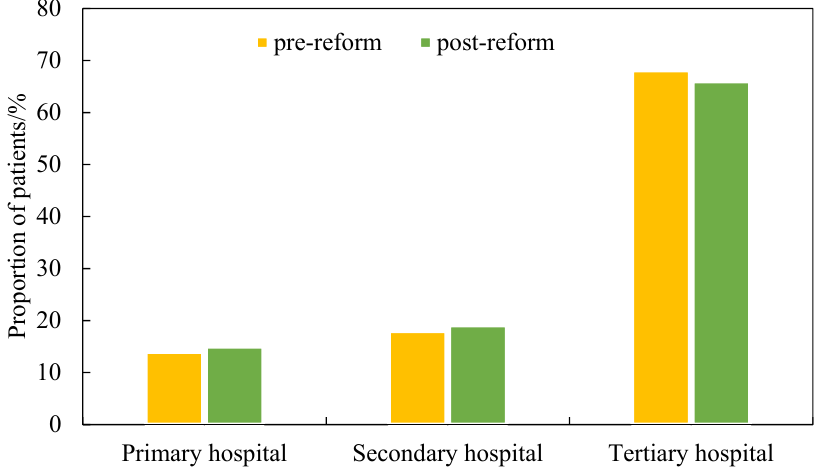
Figure 2. Distributions of patients at different levels of hospitals both pre-reform and post-reform. Spatially, the pre-reform and post-reform patterns of tertiary hospital choices were compared by computing the difference of the percentage of patients who sought healthcare in tertiary hospitals by subdistricts. This difference is presented in the form of multiples of standard deviations (Figure 3). Multiples close to 0 imply a higher degree of consistency and vice versa. This study assumes that there is no significant difference if the multiples range between − 0.5 and 0.5 [13]. After the reform, the preference for tertiary hospitals of patients who lived in subdistricts far from tertiary hospitals decreased. For example, before the reform, patients in the subdistricts Changyang and Yancun were more likely to seek healthcare in Liangxiang Hospital (i.e., a tertiary hospital), whereas the likelihood decreased after the reform. However, for patients near tertiary hospitals, the effects of Beijing’s public hospital reform in 2017 varied by core urban areas and suburban areas. The effect slightly increased the proportion of patients choosing tertiary hospitals in core areas but had no obvious effect on patients in suburban areas. This result is reasonable because the crowdedness of tertiary hospitals in core urban areas decreased after the reform and, thus, more patients were attracted nearby. Tertiary hospitals in suburban areas were not as crowded as those in the core urban areas, even before the reform. Thus, the reform